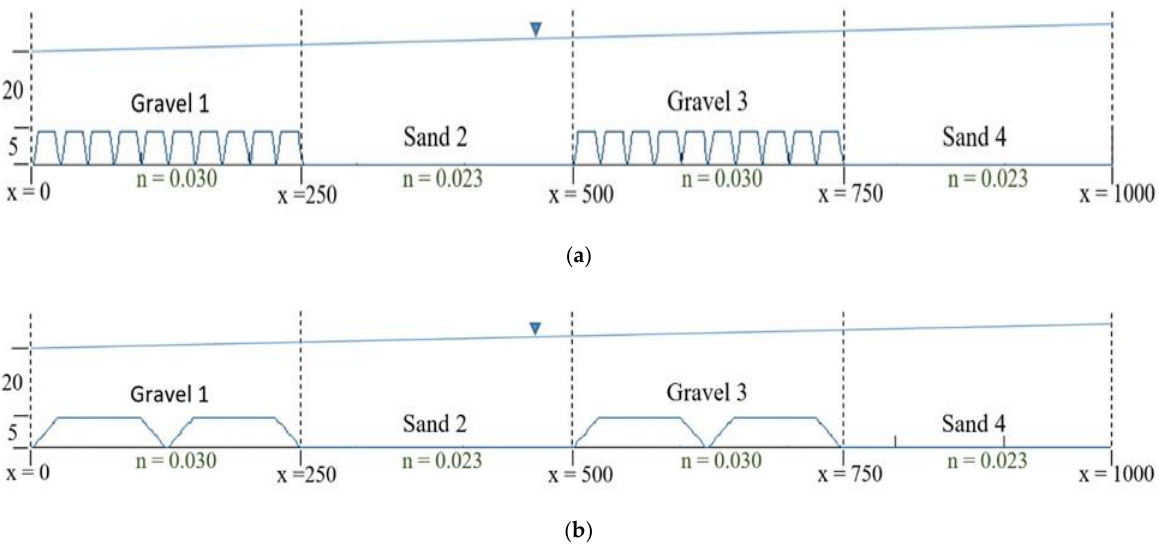
Figure 6. Base width (b w ) of the gravel pieces of the streambed is varied to investigate the effect of base width variation over hyporheic exchange. ID of the model setups are gpt5 × 10 ( a ), and gpt5 × 125 ( b ). All units are in mm.